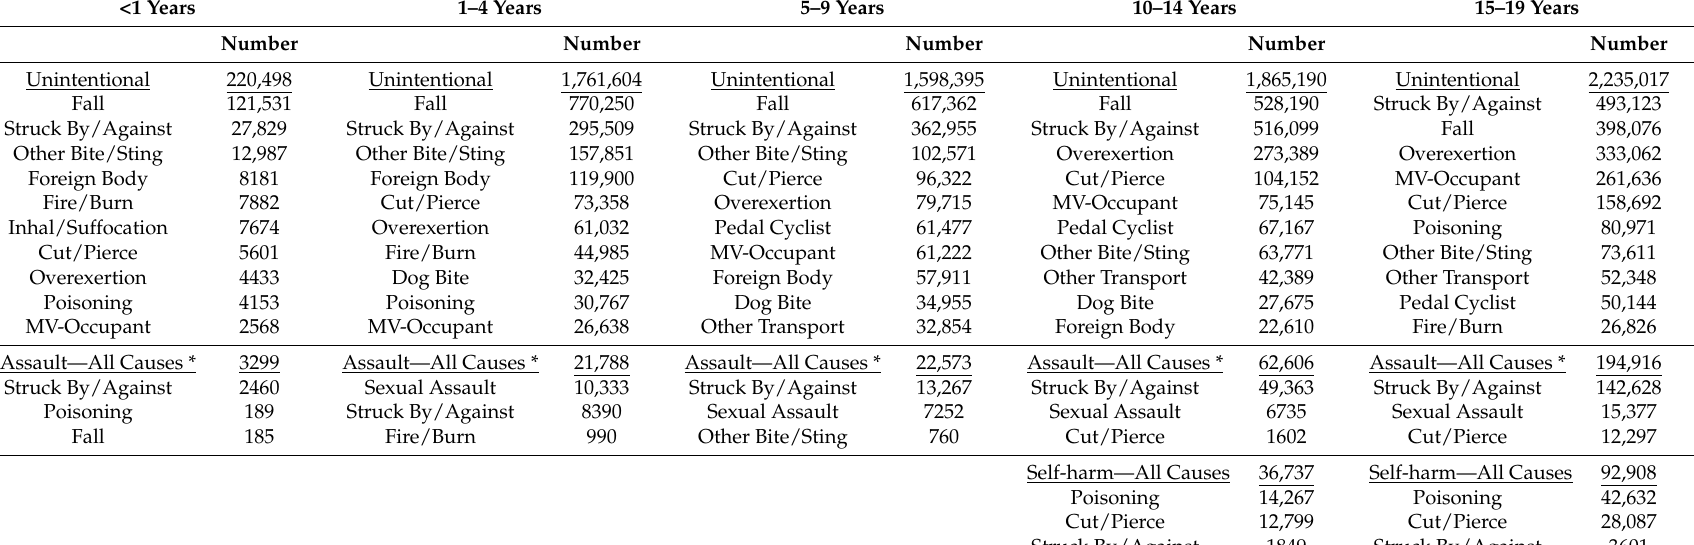
Table 3. Leading causes of non-fatal injuries among youth aged 0–19 years, National Electronic Injury Surveillance System-All Injury Program, United States,